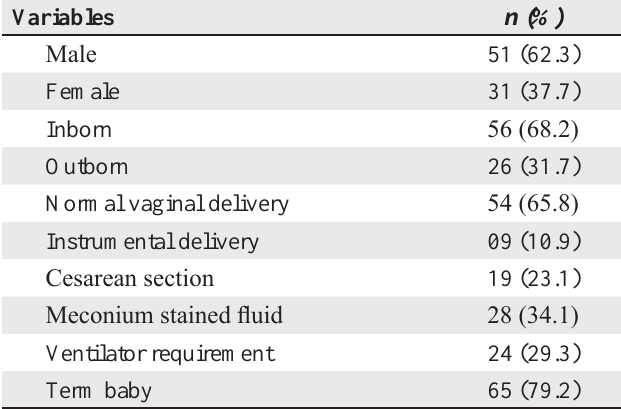
Table 1 : Clinical profile of asphyxiated